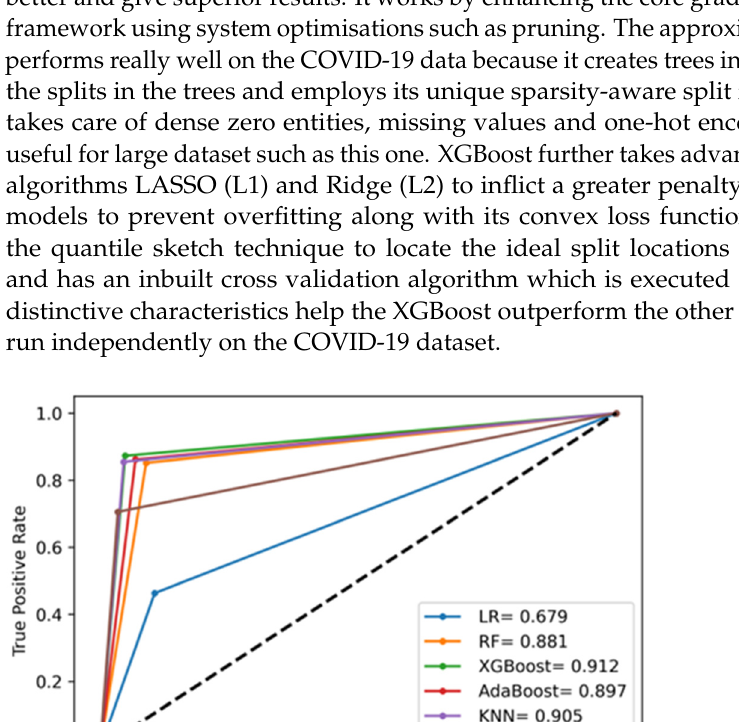
Table 3. Summary of the results obtained by various machine learning models used in this research (in percentage).